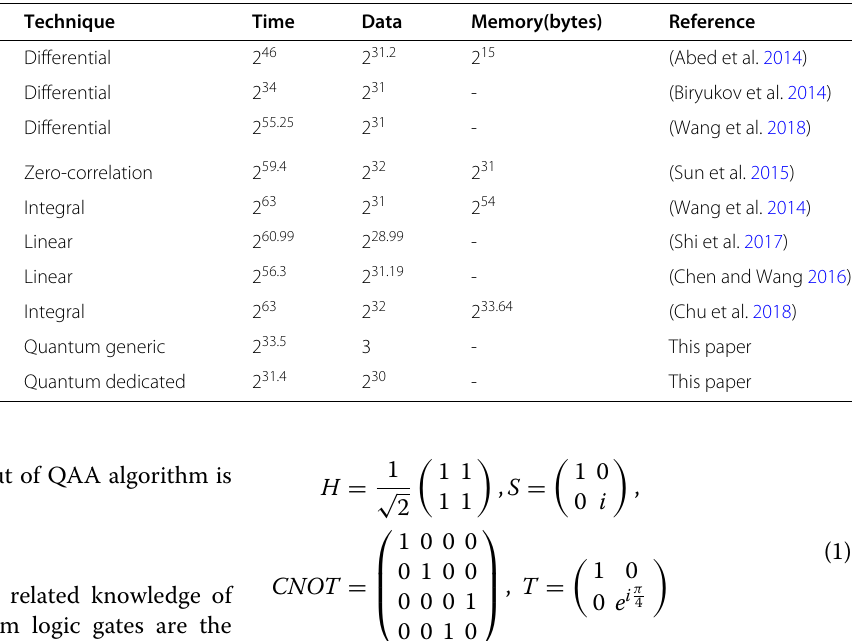
Table 3 Summary of some attacks on SIMON32/64